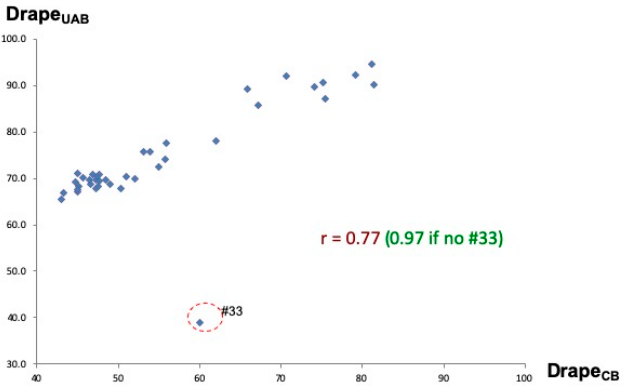
Figure 6. Cusick drape Data vs. Rectified UCD and Cotton (n = 38) (data not available for Samples #9 and #10).